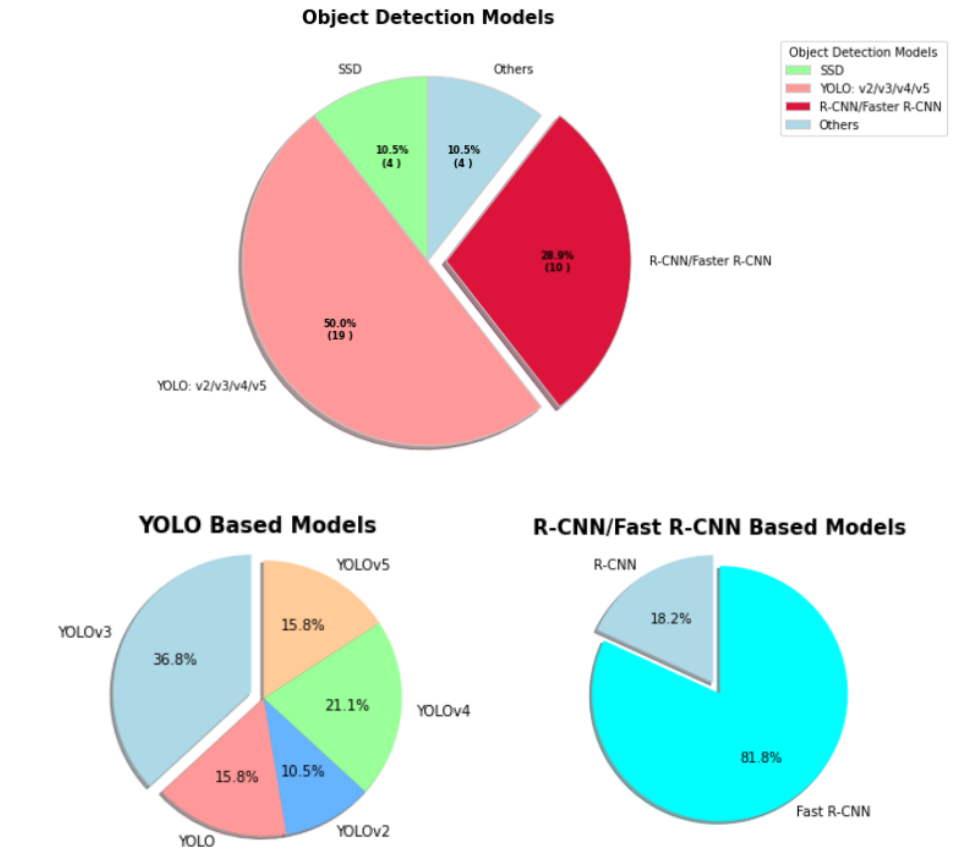
Figure 5. The rate of percentages are used in various object detection models for COVID-19. The most used models are shown in a sub-chart for proper